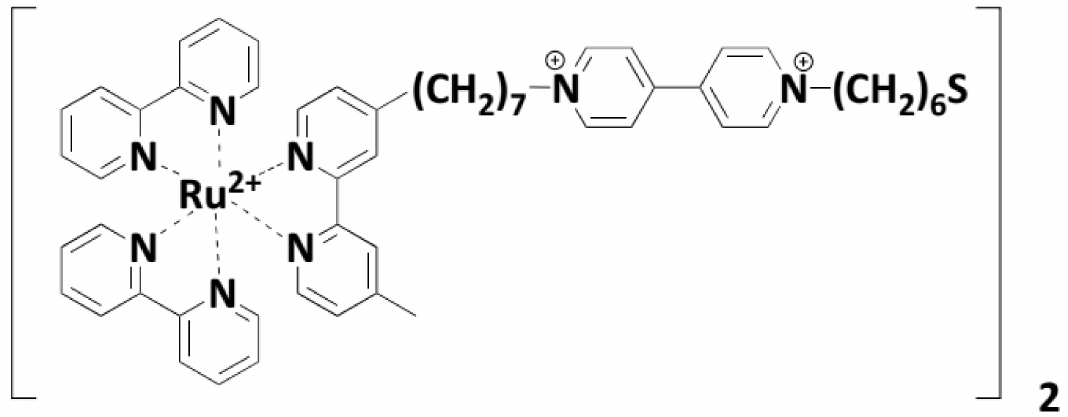
Figure 16. Viologen linked thiol-Ru complex imbeded onto Au NPs, Reprinted with permission from reference [133], Elsevier,